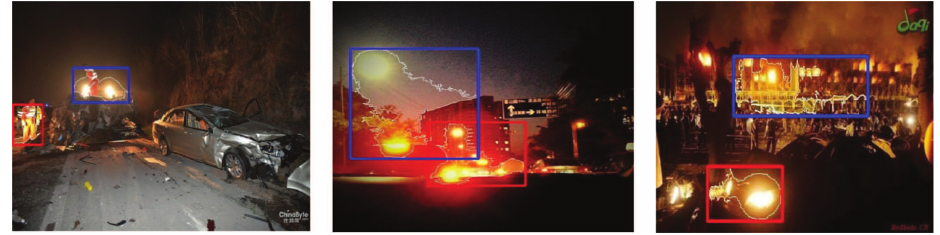
Figure 15: Lights that are Misinterpreted as